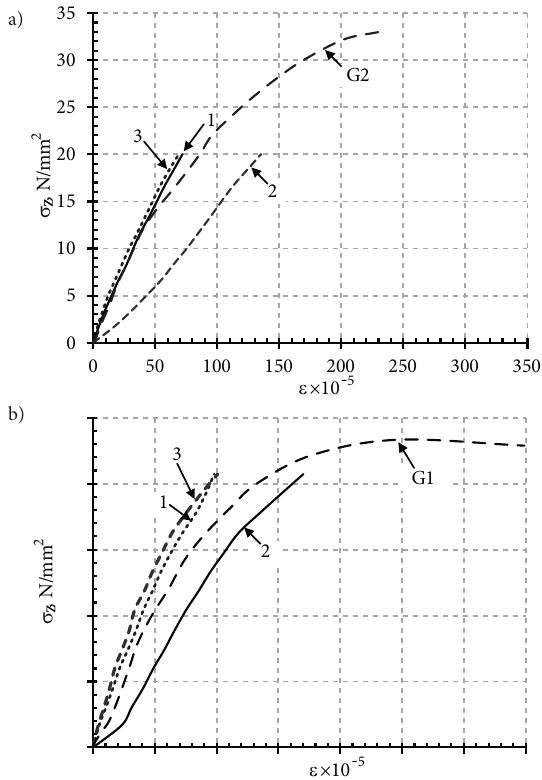
Fig. 9. Deformations of masonry set with concrete infill (a) P6-20 and (b) P6-30 blocks: 1 – longitudinal deformation of a specimen; 2 – longitudinal deformation of the bed joint, 3 – longitudinal deformation of a block; G1 and G2 – longitudinal deformation of the infill concrete control sample